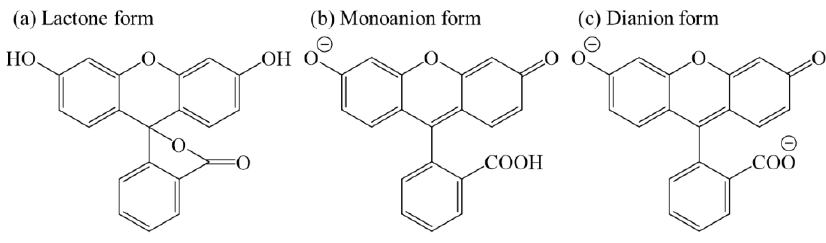
Figure 3. ( a ) Dependence of PL enhancement factor ( E RH ) on RH, at room temperature. Dependence of E NH3 on [NH 3 ], at various RH values (RH = 17 ( b ), 37 ( c ), 59 ( d ), and ( e ) 78%).